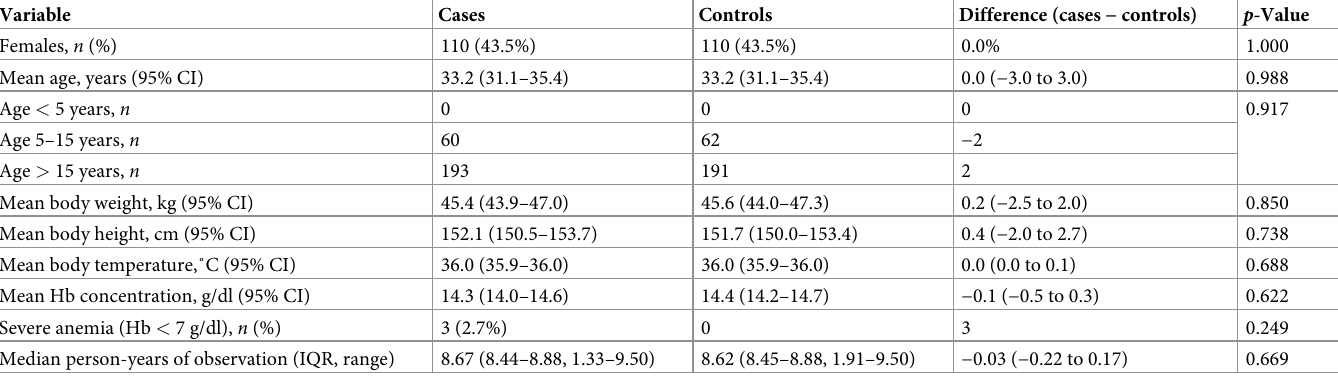
Table 6. Baseline characteristics for individuals in the case–control